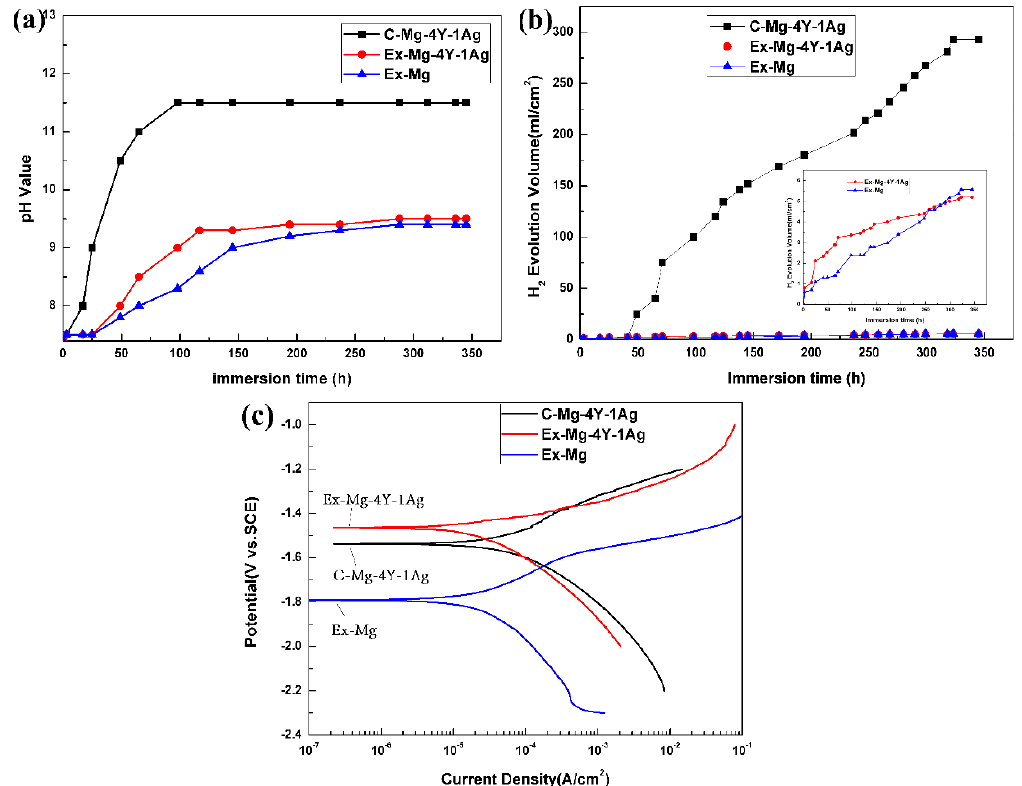
Figure 3. Graphs charting the dynamic degradation of the C-Mg-4Y-1Ag, Ex-Mg-4Y-1Ag and Ex-Mg samples in PBS as a function of time: ( a ) pH value of PBS; ( b ) volume of evolved hydrogen; and ( c ) potentiodynamic polarization curves.